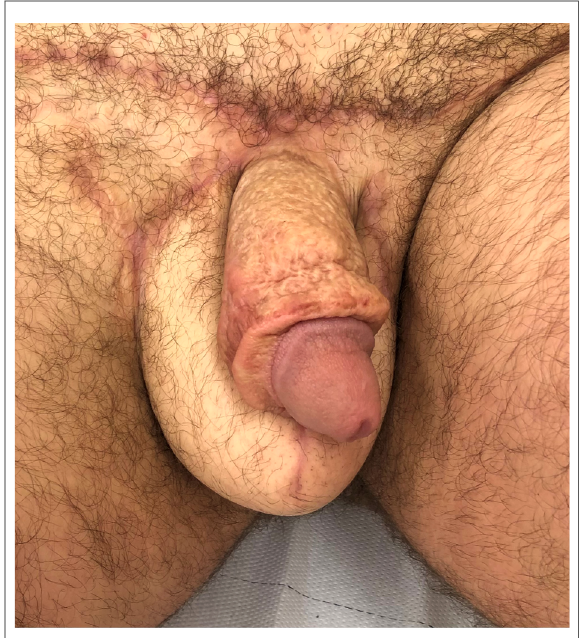
FIGURE 2 9 Months postoperative view of the same patient. Note excellent mimicry of the thigh skin to a native scrotum.